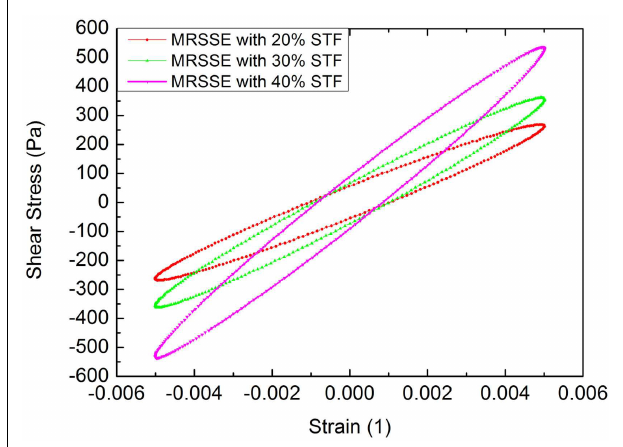
FIGURE 9 | Strain–stress curves of MRSSE with different STF fraction .